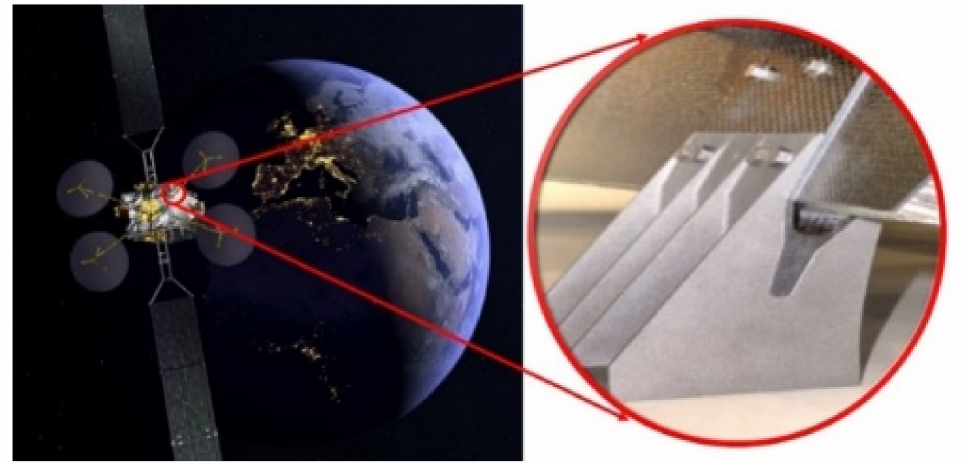
Figure 1. AM-made titanium brackets are used in satellites